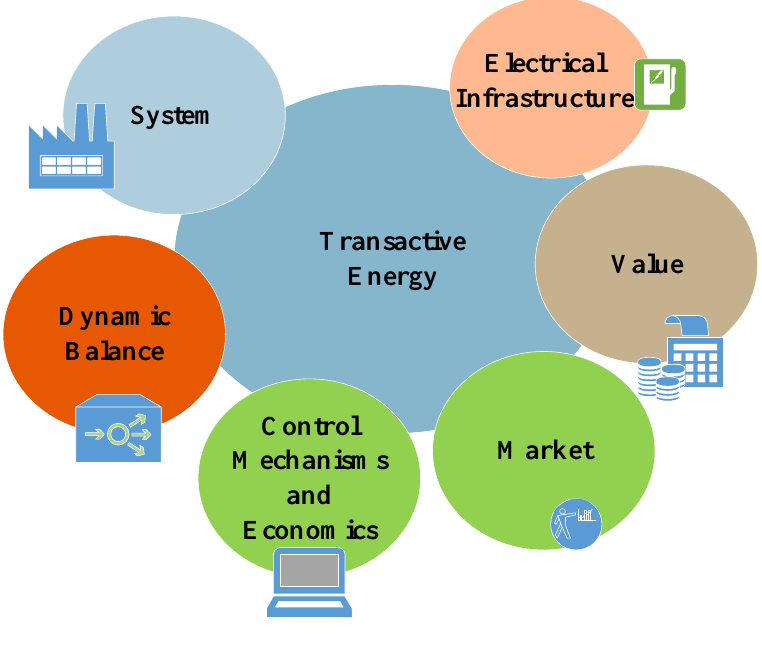
Figure 2. Transactive Energy Concept